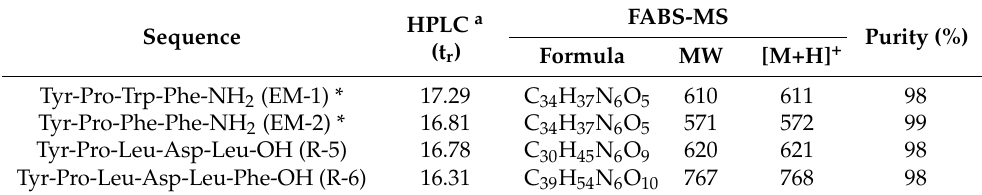
Table 1. Physicochemical data of endomorphins and rubiscolins.